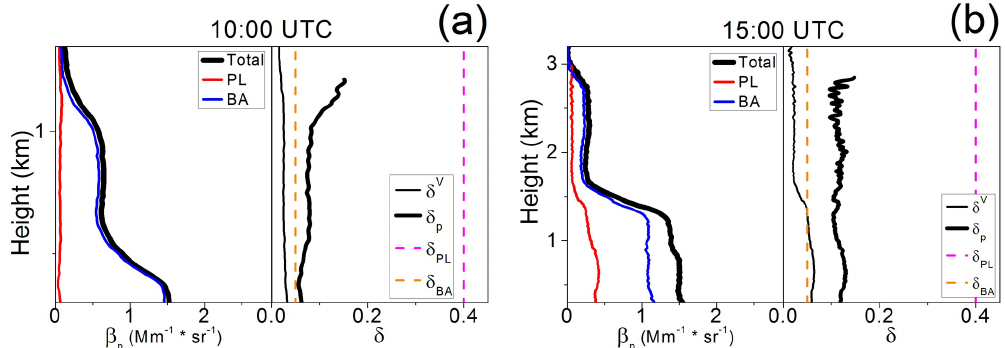
Figure 8. The same as Fig. 4 but for the pollen event on 23 March 2016 at (a) 10:00UTC (no PL detection) and (b) 15:00UTC (enhanced PL occurrence). Specific depolarization ratios selected for each pure aerosol component are also shown by vertical dashed lines (see legend for